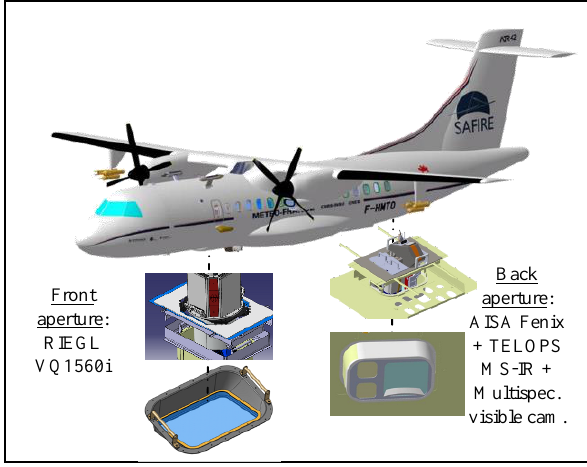
Figure 9. Integration of the sensors in the